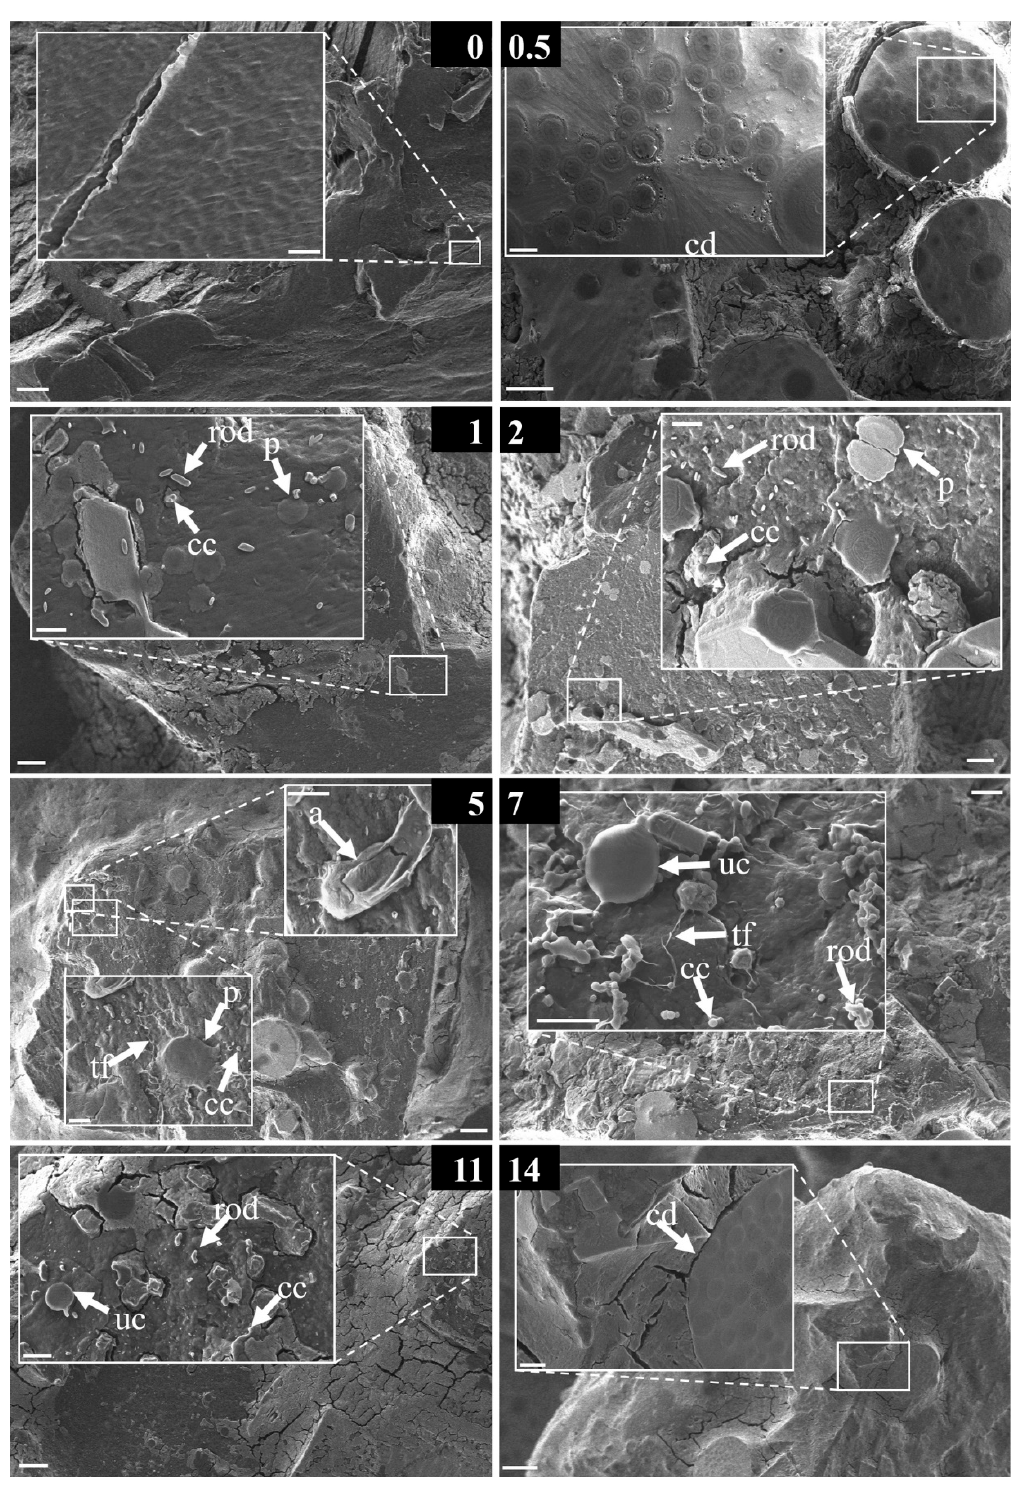
Figure 7. Scanning electron microscopy images of PET incubated in seawater. Numbers in black boxes indicate incubation times in days (0 = raw material, 0.5 = half day, 1 = one day, 2 = two days, 5 = five days, 7 = seven days, 11 = eleven days, 14 = 14 days of incubation). Microorganismal structures are highlighted with arrows. a = non-assignable structure, rod= rod/vibrio-shaped bacteria, cc = coccoid bacteria, p = platelet structure, tf = thin film, uc = unicellular structure. Scale bar: Large image 10 µm, magnified image 2 µm.